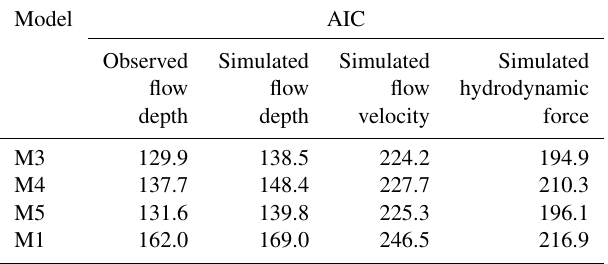
Table 7. Likelihood ratio test summary for all available observed and simulated tsunami intensity measures of DB_Sunda2018. Model p value